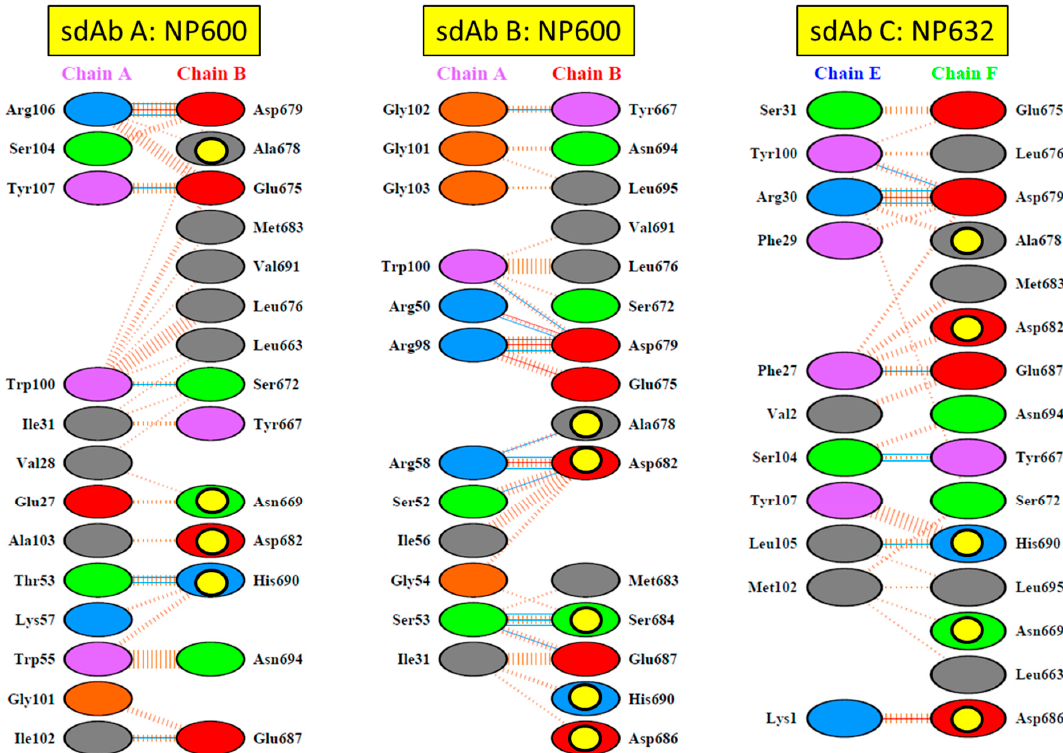
Figure 11. Schematic interaction maps of the three anti-MARV sdAb with the MARV Musoke NP C-terminus based on analysis of sdAb A / NP600 (PDB ID: 6APP), sdAb B / NP600 (PDB ID: 4W2O), sdAb C / NP632 (PDB ID: 4W2Q) using PDBSum. Residues are labelled as follows; Positive = His, Lys, Arg; negative = Asp, Glu; neutral = Ser, Thr, Asn, Gln; aliphatic = Ala, Val, Leu, Ile, Met; aromatic = Phe, Tyr, Trp; Pro, Gly. Interactions are labelled as follows; salt bridges, red lines; hydrogen bonds, blue lines; non-bonded contacts, striped brown lines with the width of the lines proportional to the number of atomic contacts. The yellow circles highlight those residues that are mutated in the MLAV NP.